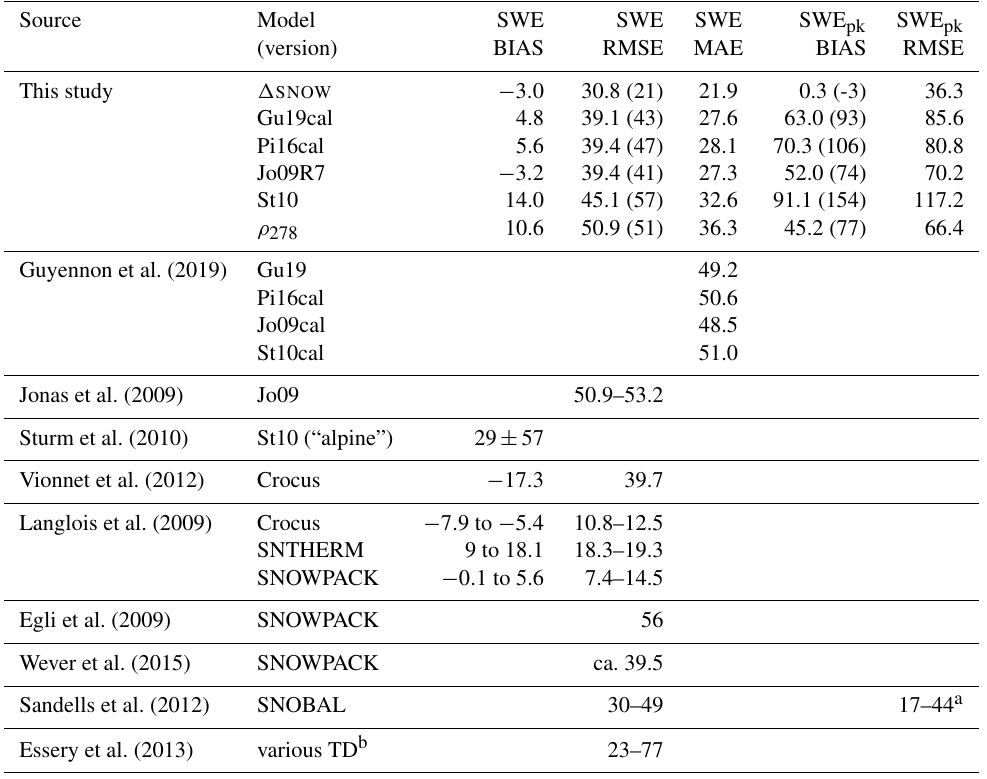
Table 4. Overview on SWE accuracies of different models and studies. The numbers in brackets represent the results for the example portrayed in Figs. 3 and 4 from station Kössen in 2008/09. Units are kgm − 2 , TD is short for thermodynamic snow models. For model abbreviations, see caption of Fig.